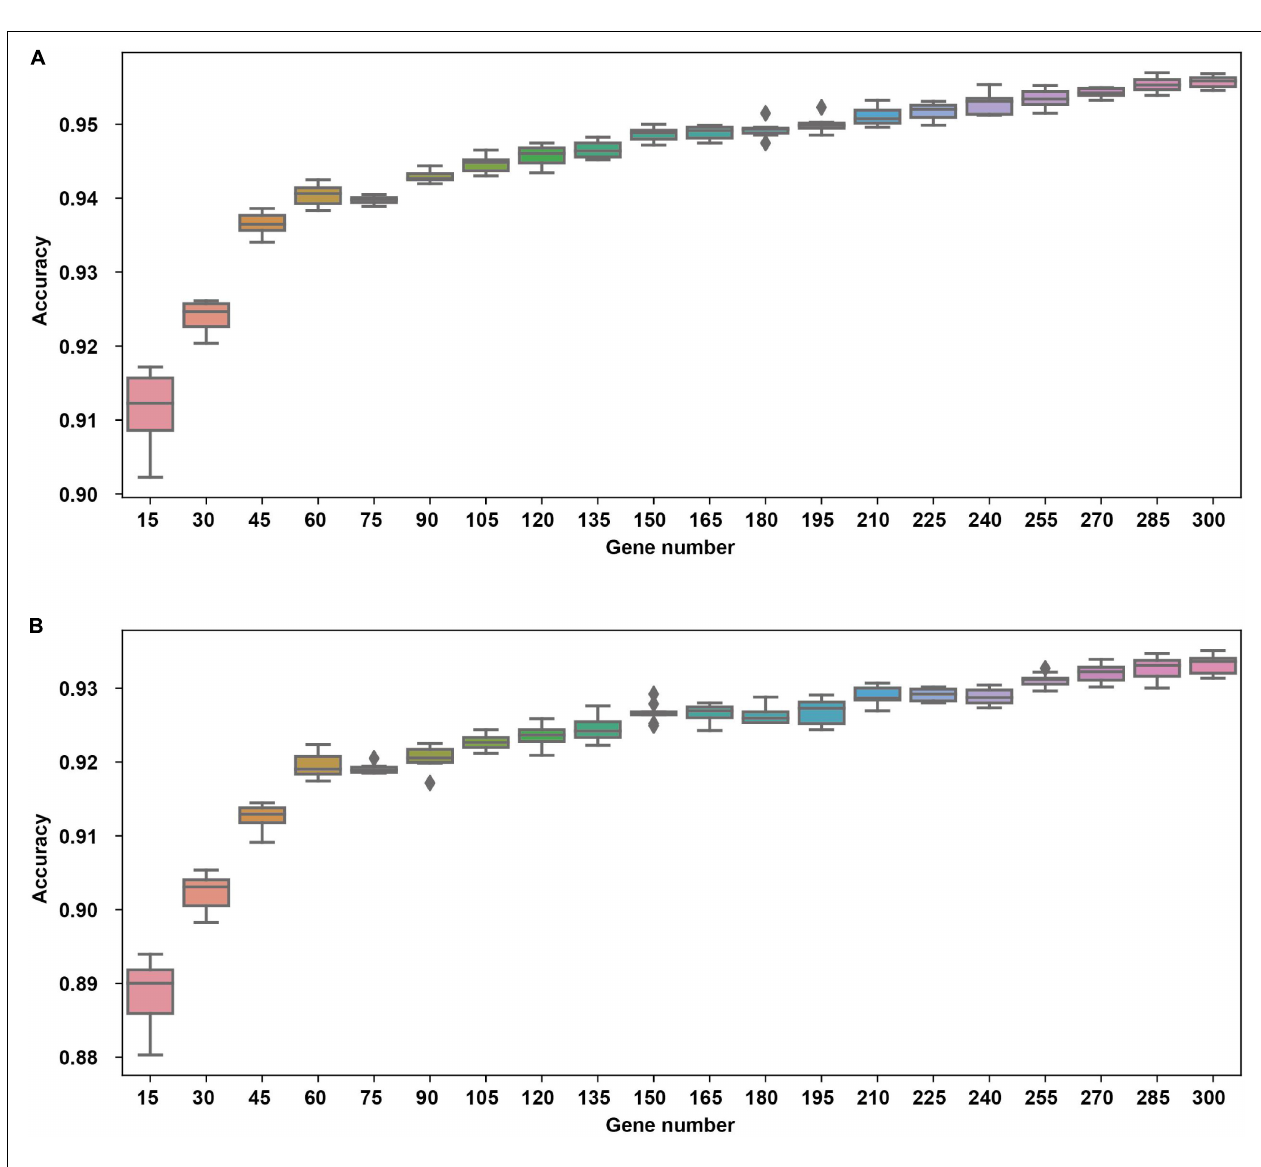
FIGURE 2 | The cross validation accuracy of different gene numbers using neural network (A) and logistic regression (B) .